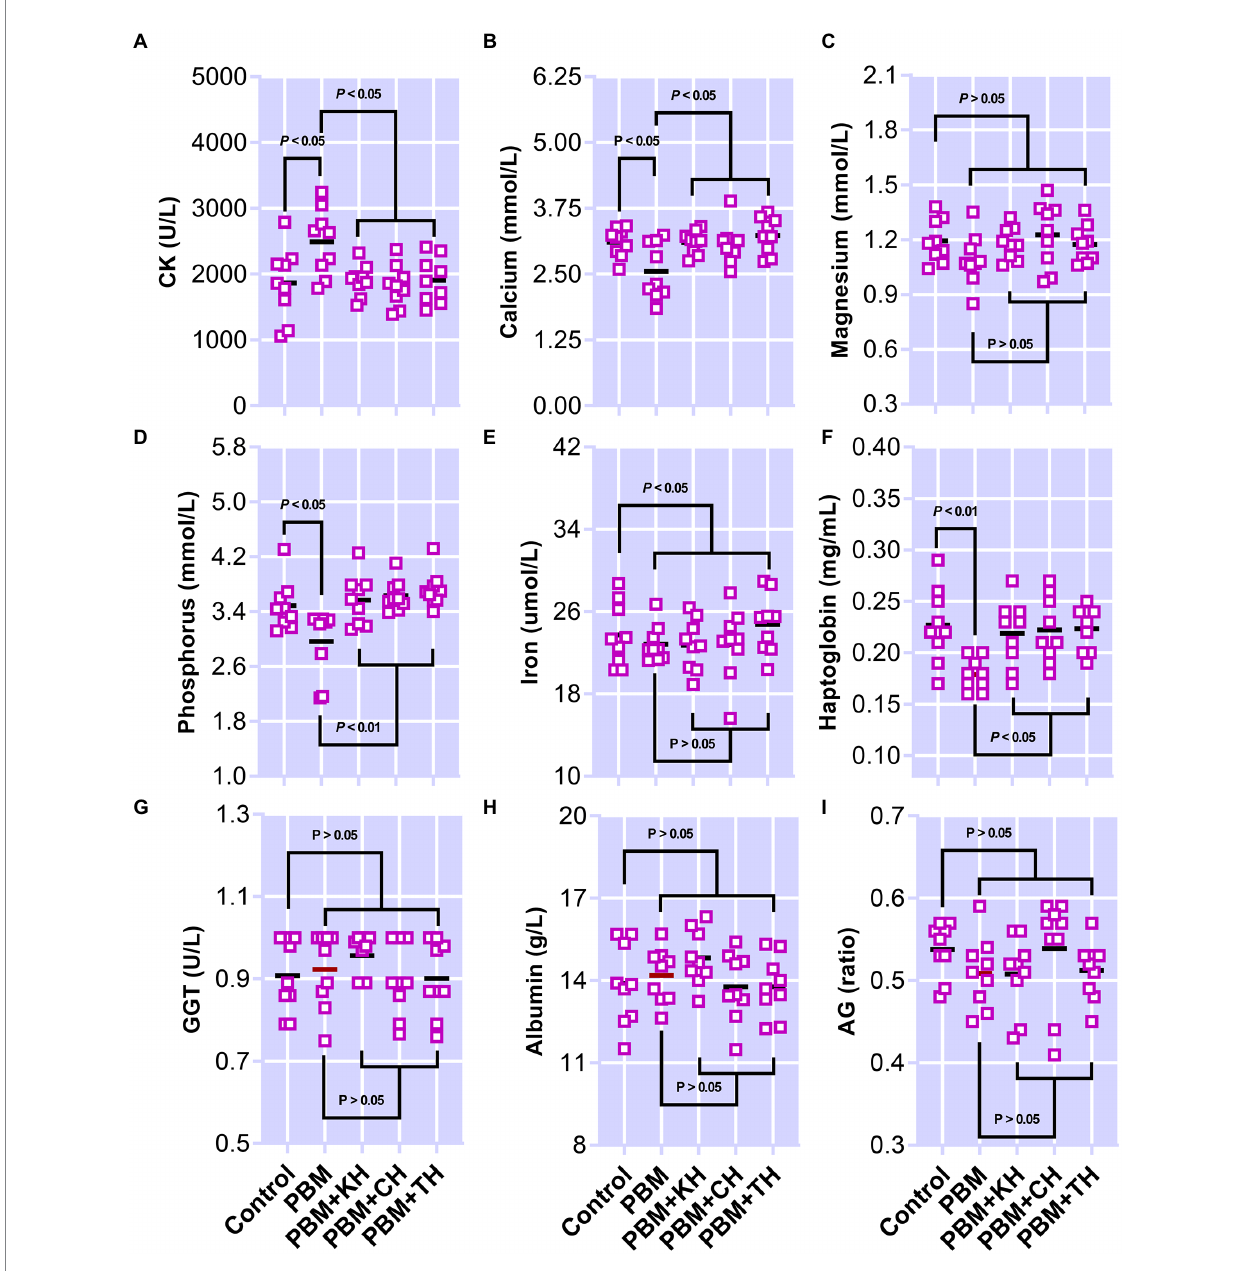
FIGURE 8 Serum Creatine kinase (CK; A ), calcium (B) , Magnesium (Mg; C ), inorganic phosphate (D) , iron (E) , haptoglobin (F) , gamma-glutamyltransferase (GGT; G ), albumin (H) , and AG (I) of barramundi fed FM-based control, PBM alone, or supplemented with various FPHs supplemented diet over a period of 42